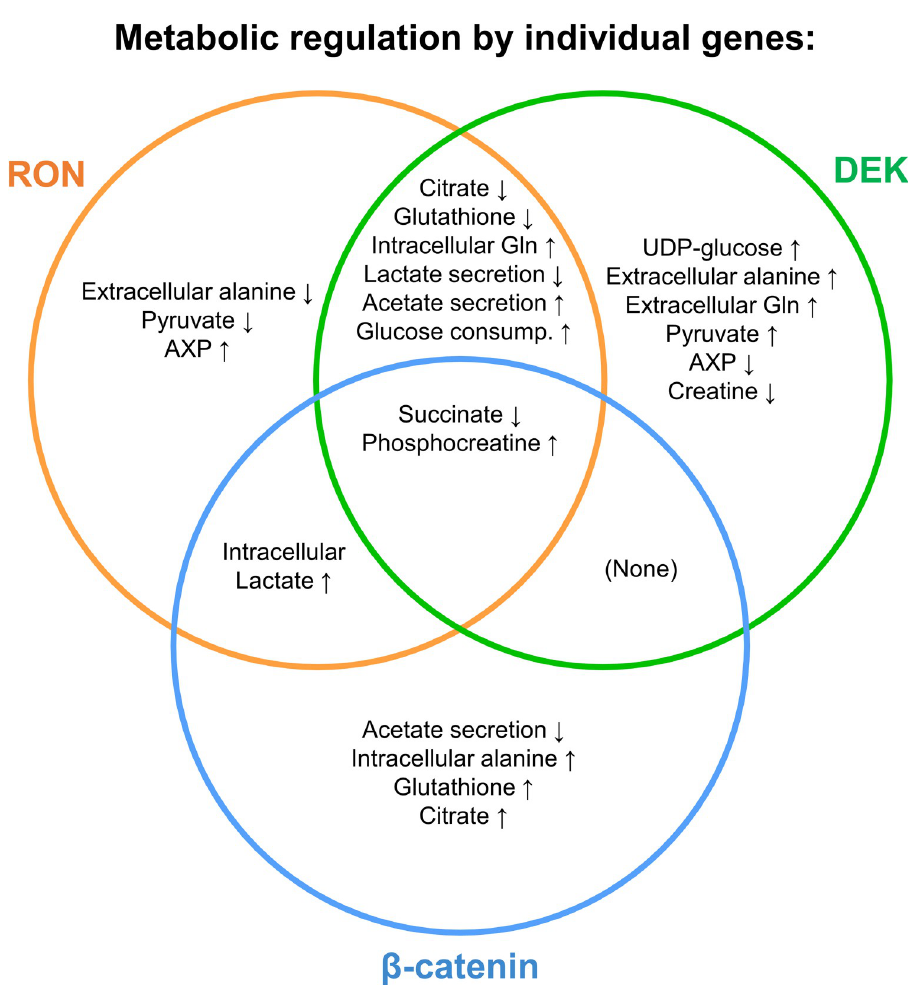
Fig 6. Unique and overlapping metabolic alterations by RON, DEK, or β -catenin in murine breast cancer cells. Venn diagram summary of results from Figs 1–4.